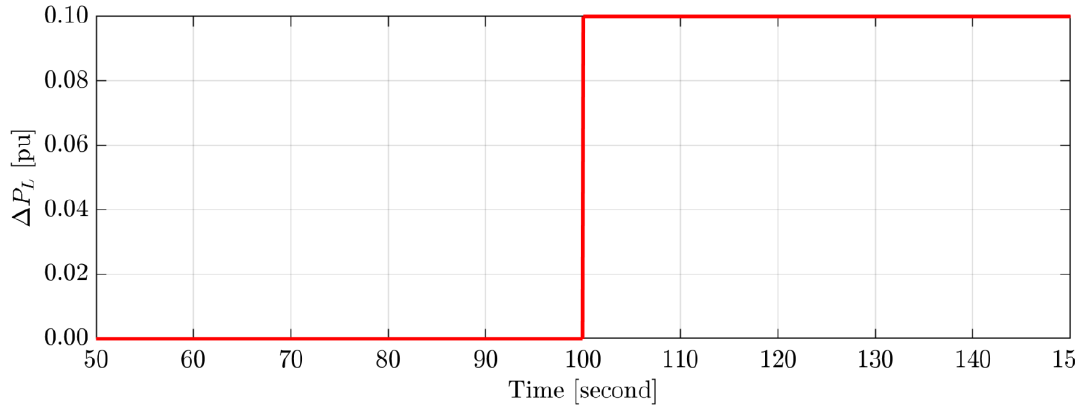
Figure 11. Sudden load change for the case 2.